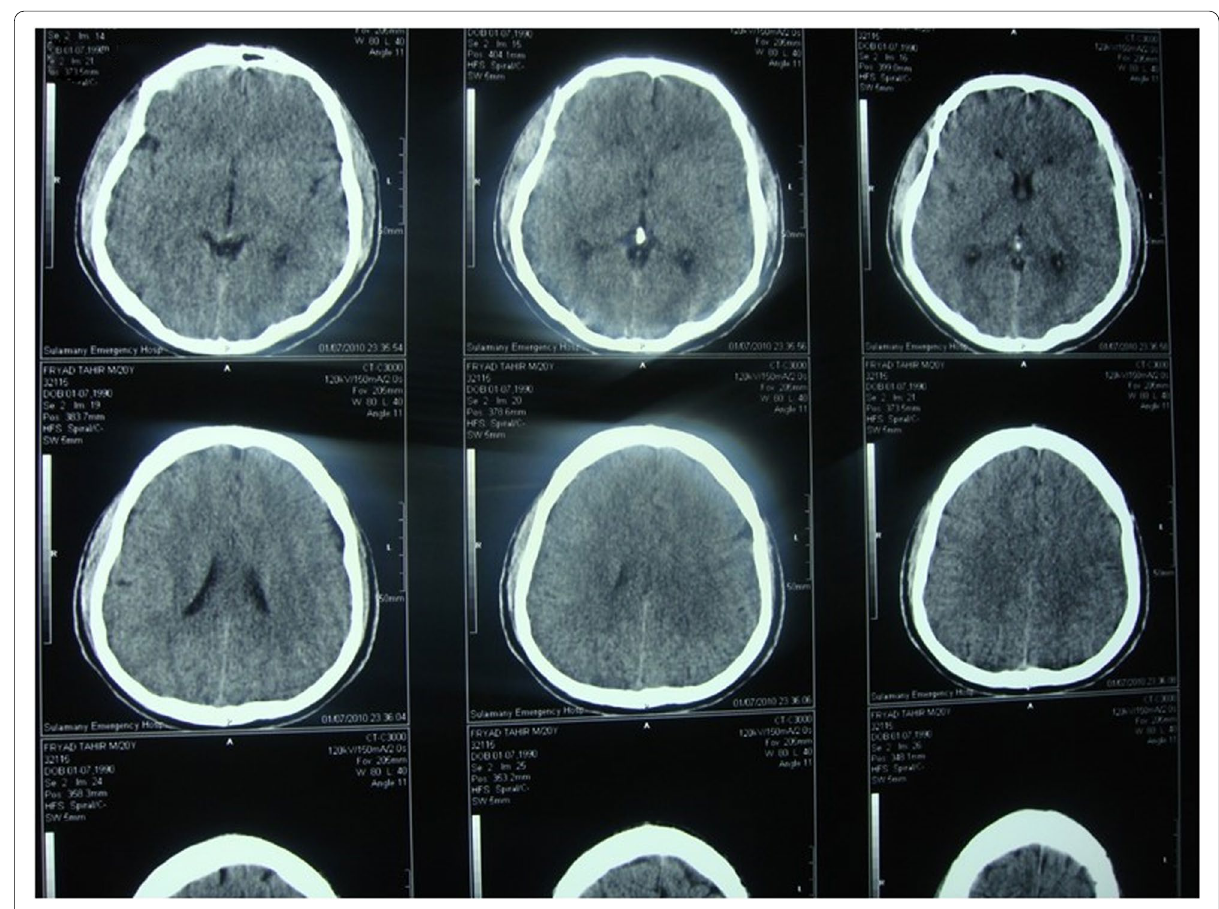
Fig. 13 Brain CT scan in case 2 showing brain